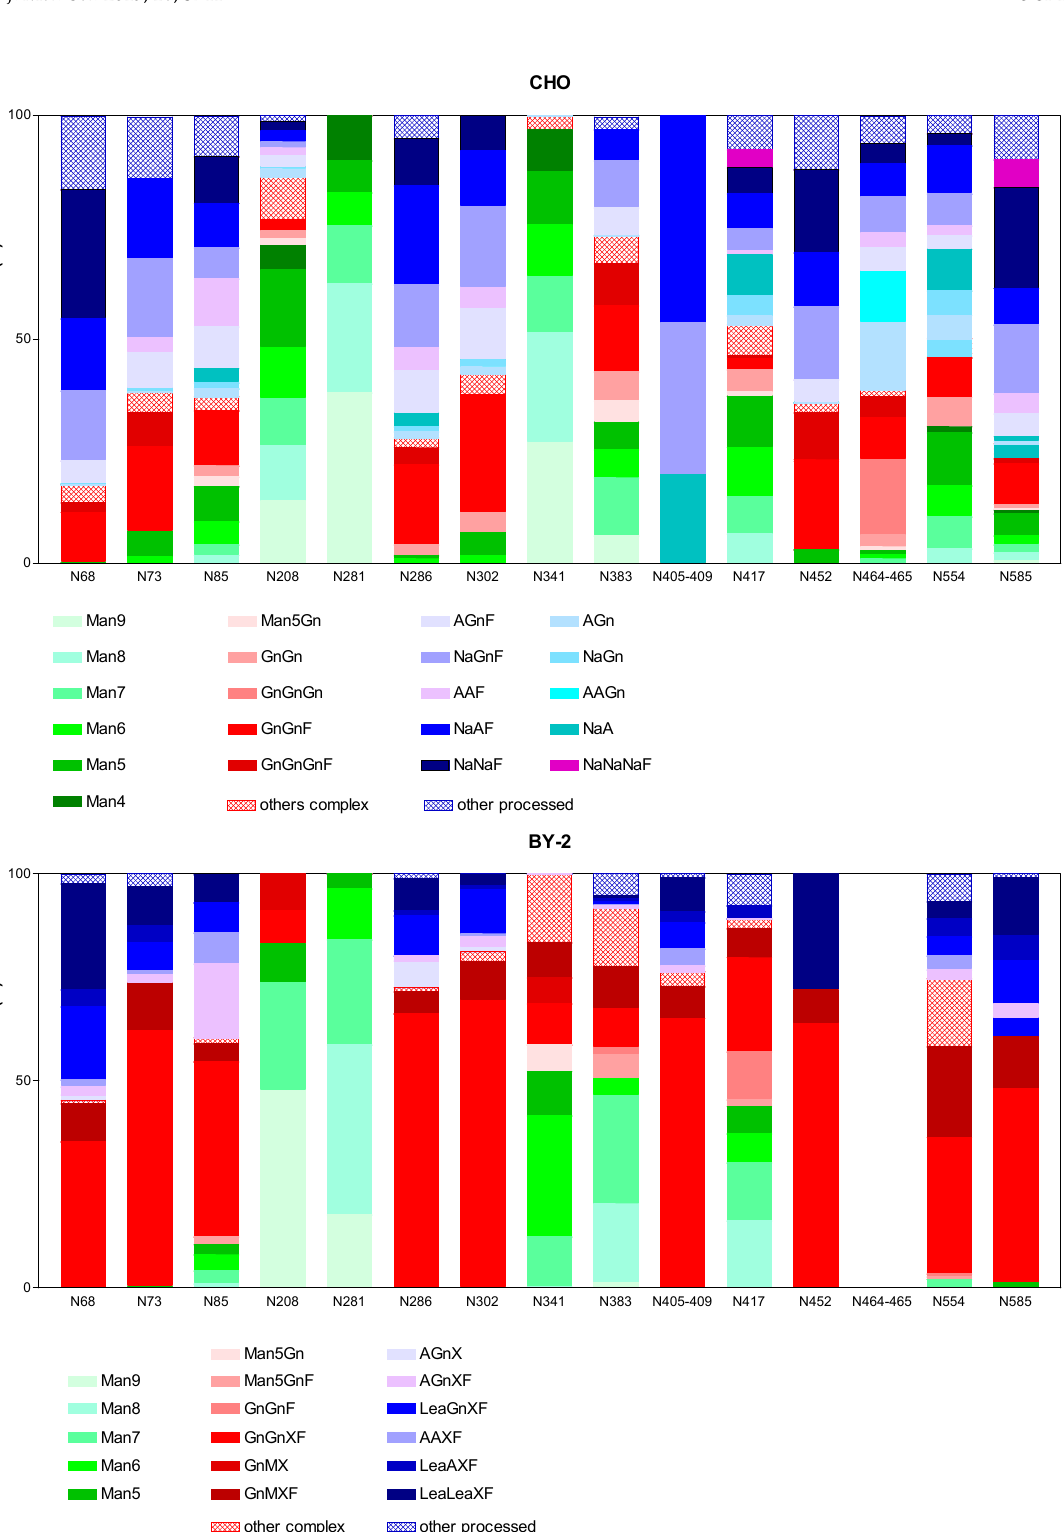
Figure 4. Quantification of the relative abundance of N-glycans detected by mass spectrometry at each glycosite on gB ectodomain expressed in CHO and BY-2 cells. N-glycans detected ( > 5%) are represented and abbreviated according to the ProGlycAn system. The quantitative data derived from a single analysis for both samples. Glycans are assigned into three groups: (1) oligomannosidic structures (in green); (2) hybrid / complex structures exhibiting terminal GlcNAc (in red); (3) highly processed complex-N-glycans (in blue). Glycans present in less than 5% are grouped in “others” and are hatched.